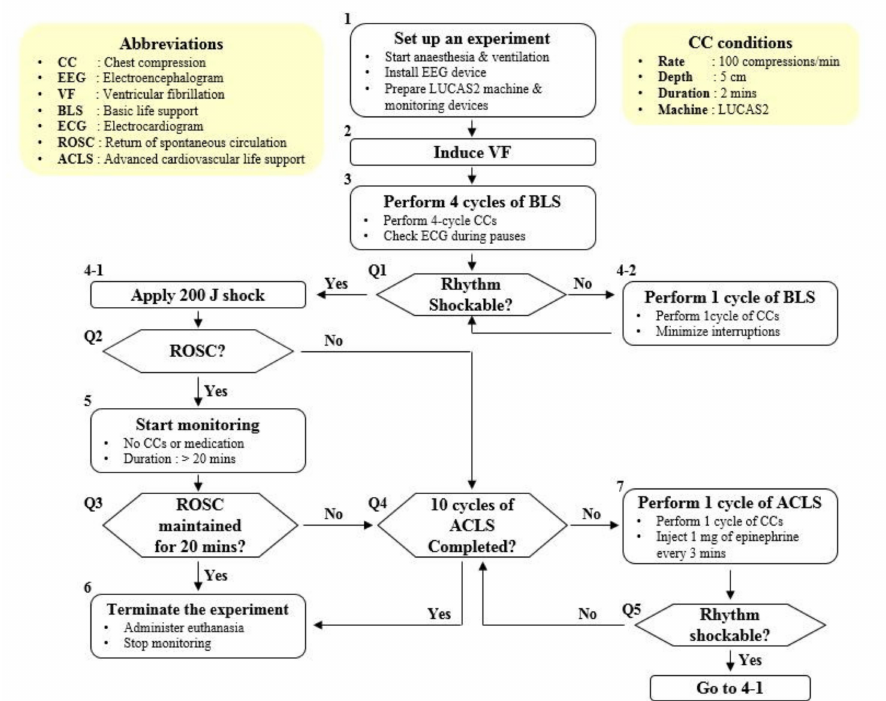
Figure 1. Flow chart of the study design [17]: After the initial experimental setup was